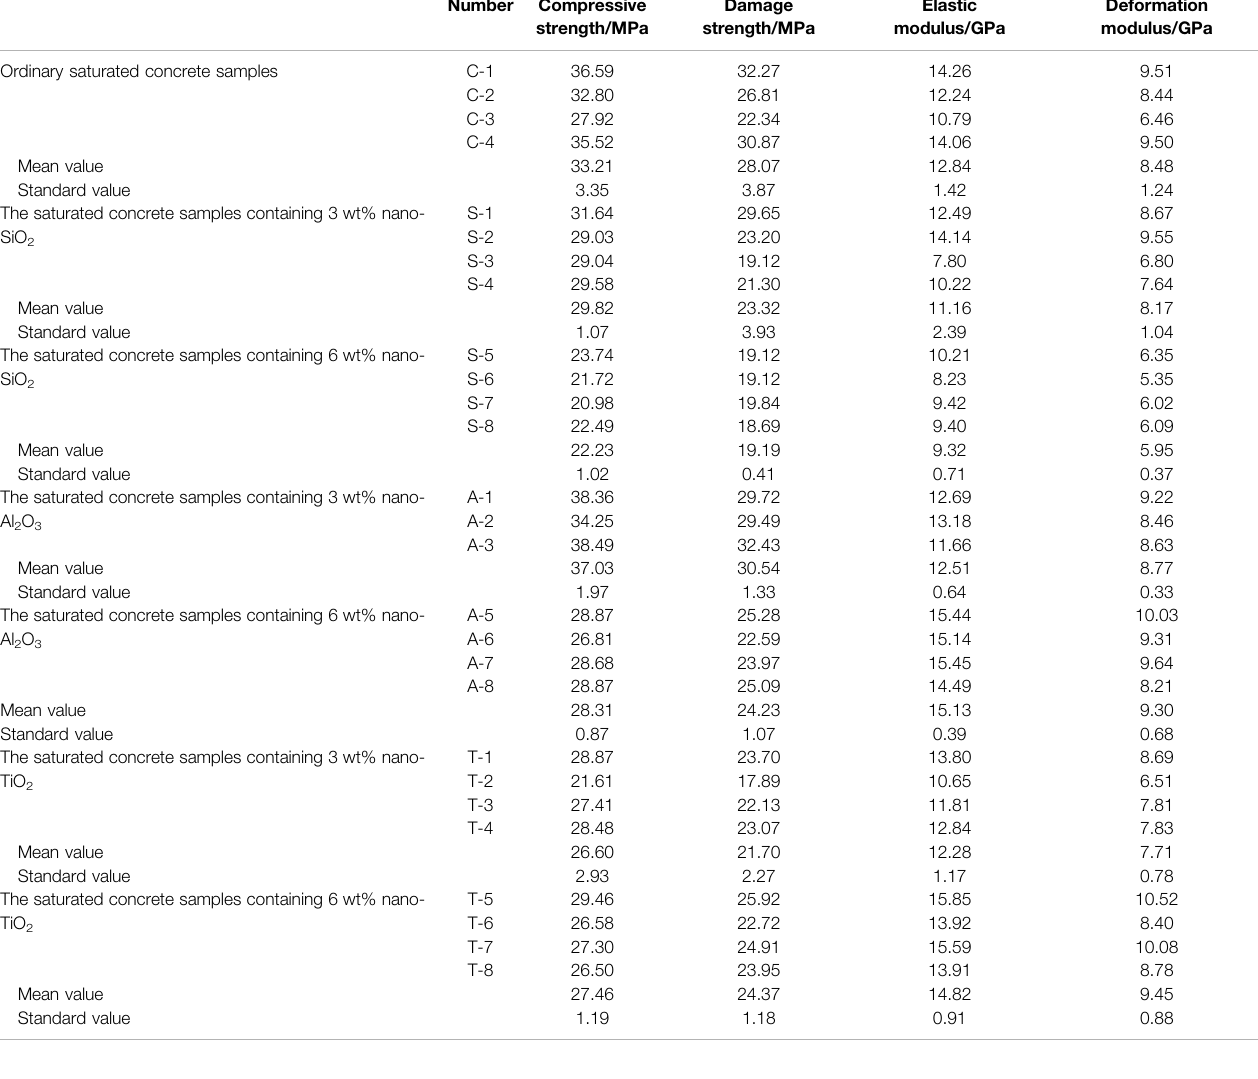
Number Compressive